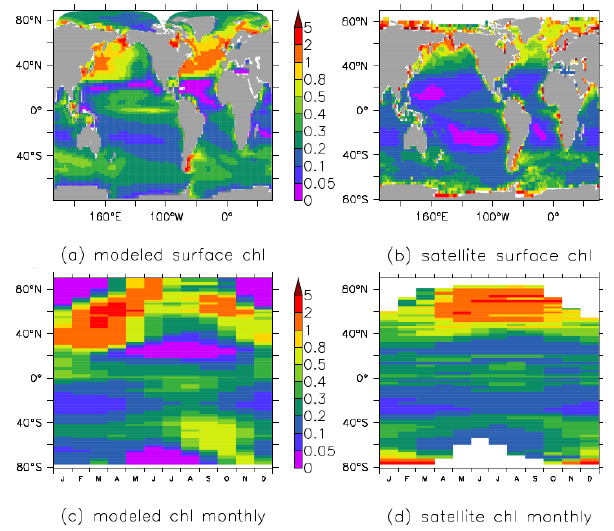
Figure 5. Comparison of (b, d) chlorophyll concentration in mgm − 3 from SeaWiFS satellite observation (Yoder and Kennelly, 2003) used in earlier similar studies and (a, c) modeled using GFDL ESM CM2Mc with BLING biogeochemistry. Data shown are from the chl&CDM model run described in Sect. 4 of this paper. Annual average surface distributions are shown in (a, b) and monthly aver- age surface concentrations by latitude are shown in (c, d) .